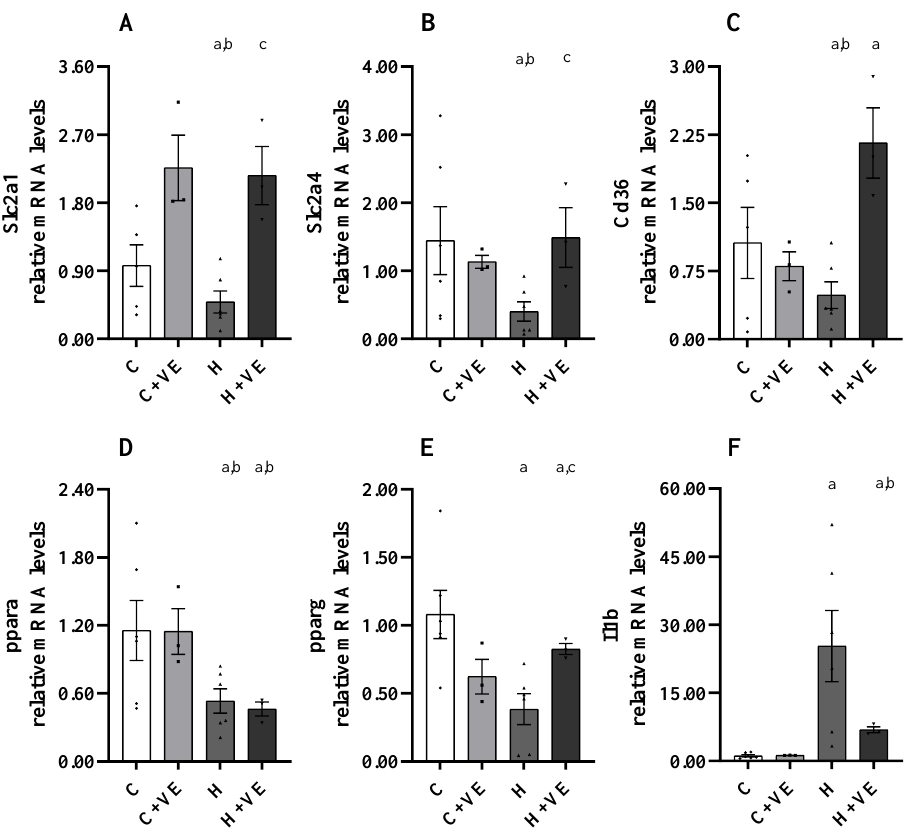
Figure 7. Relative mRNA quantification by qPCR of indicated genes ( Slc2a1 ; Slc2a4 ; Cd36 ; Ppara ; Pparg ; Il1b , panels ( A – F ), respectively). C control rats; C + VE, vitamin-E-fed rats; H hyperthyroid rats; H + VE hyperthyroid and vitamin-E-fed rats. Expression values are shown as relative mRNA levels compared to C group applying 2 −ΔΔCt method. Actb and B2m were used as housekeeping genes. The histograms display for the different groups the means ± SEM. Normal data distribution has been assessed by Shapiro – Wilk test and the statistical significance ( p value ≤ 0.05) was assessed by a two- tailed (one sample or two samples) Student’s t test (a, p < 0.05 vs. C; b, p < 0.05 vs. C + VE; c, p < 0.05 vs. H).